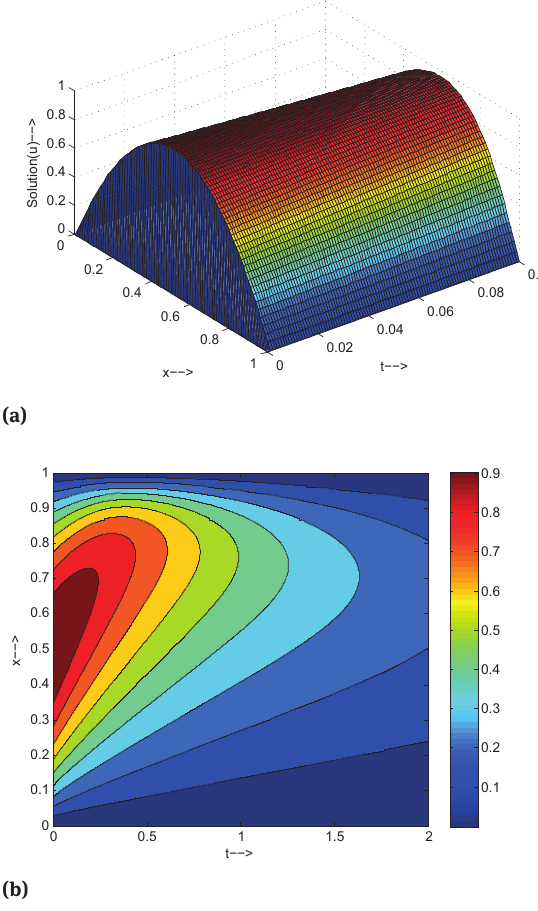
Fig. 5: Example 2: Physical behavior of numerical solutions at differ- ent times in 3D and contour for Δx = 0.0125 , ν = 0.05 , Δt = 0.001 (a) T = 0.1 (b) T = 2 .